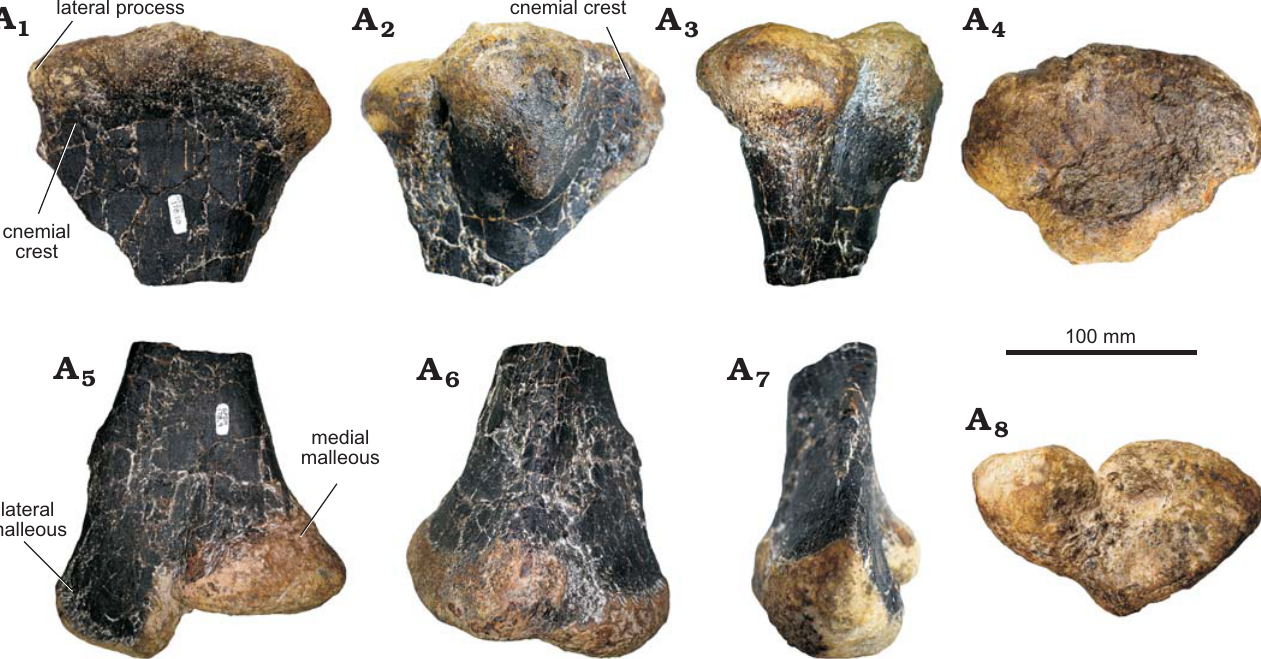
Fig. 17. Left radius of stegosaur GPDM 178, near Giffen, Cascade County, Montana; in anterior (A 1 ), posterior (A 2 ), medial (A 3 ), lateral (A 4 ), dorsal (A 5 ), and ventral (A 6 ) views.